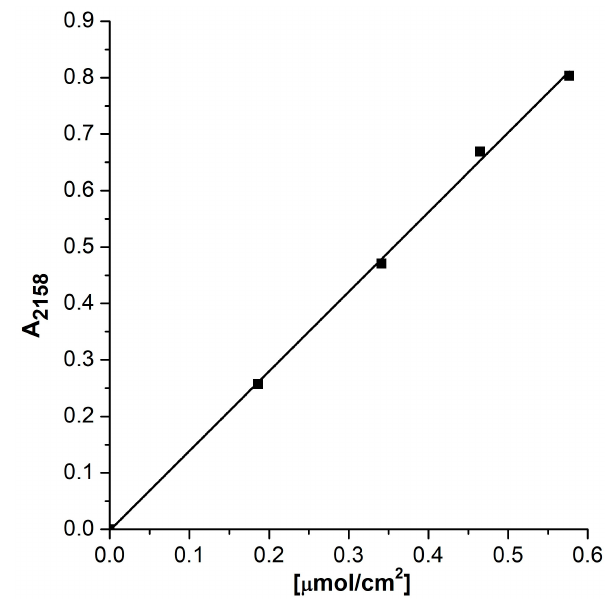
Figure 5. The intensity of the 2158 cm − 1 band of Cu + exch .–CO as a function of the amount of CO adsorbed.